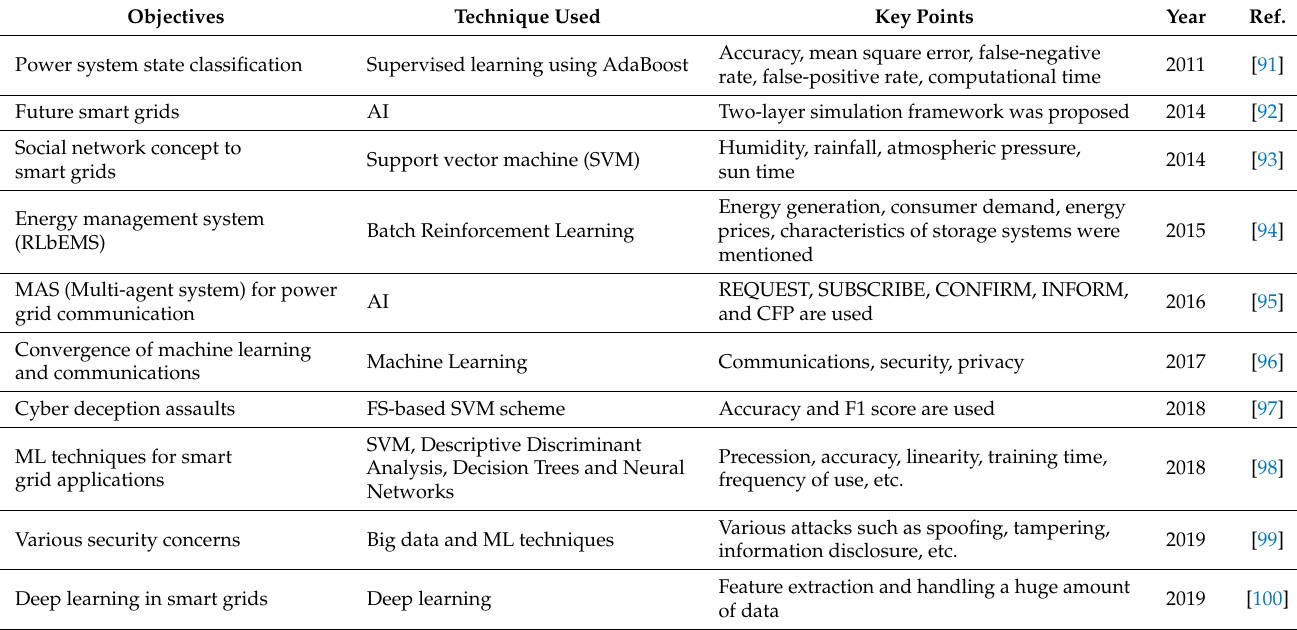
Table 9. Key applications of AI and ML in power